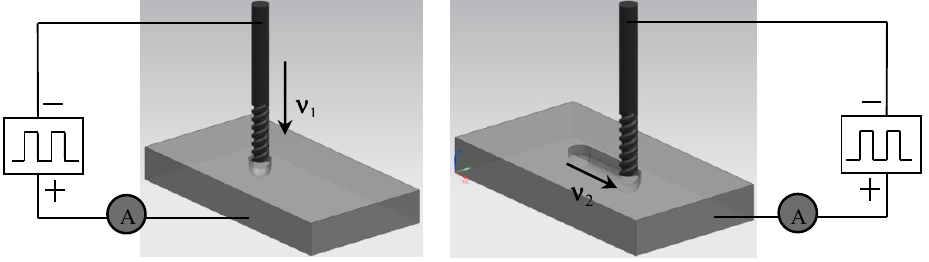
Figure 1. Process of micro-electrochemical milling.